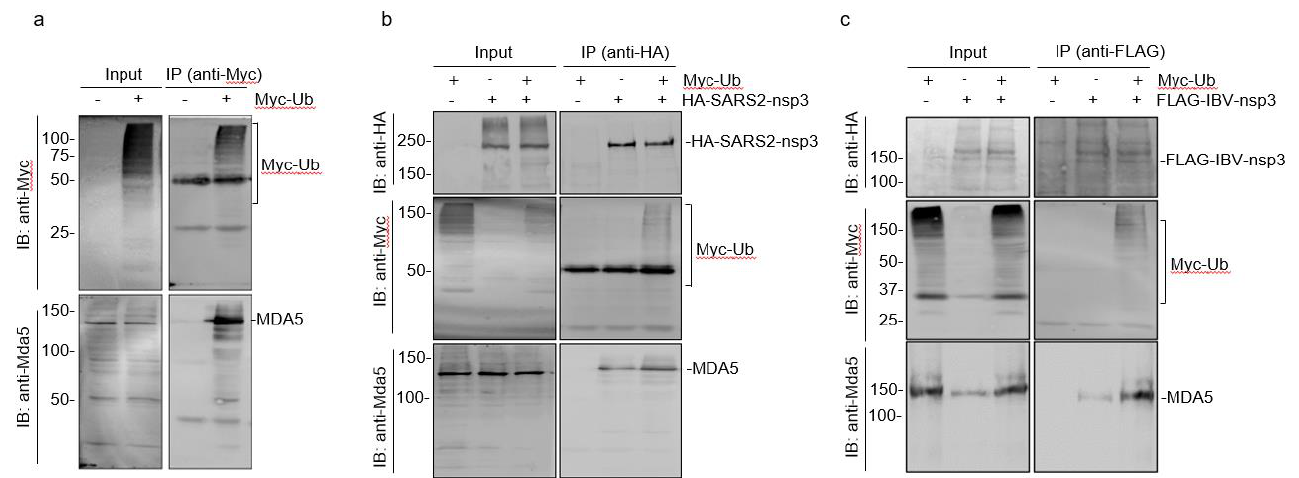
Figure 7. Interaction of ubiquitin and ubiquitinated proteins with nsp3 and MDA5. ( a ) Co-immunoprecipitation of Ub with MDA5. HEK293T cells were transfected with Myc-Ub, harvested at 24 h post-infection, total cell lysates prepared, and subjected to immunoprecipitation with anti-Myc beads. Total cell lysates and precipitates were analyzed by Western blot with anti-Myc and anti-MDA5 antibodies, respectively. Numbers on the left indicate protein sizes in kilodalton. ( b ) Co-immunoprecipitation of HA-tagged SARS-CoV-2 nsp3 with Myc-Ub and MDA5. HEK293T cells were transfected with Myc-Ub alone or together with HA-tagged SARS-CoV-2 nsp3, harvested at 24 h post-infection, total cell lysates prepared, and subjected to immunoprecipitation with anti-HA beads. Total cell lysates and precipitates were analyzed by Western blot with anti-Myc, anti-MDA5, and anti-HA antibodies, respectively. Numbers on the left indicate protein sizes in kilodalton. ( c ) Co-immunoprecipitation of Flag-tagged IBV nsp3 with Myc-Ub and MDA5. HEK293T cells were transfected with Myc-Ub alone or together with Flag-tagged IBV nsp3, harvested at 24 h post-infection, total cell lysates prepared, and subjected to immunoprecipitation with anti-Flag beads. Total cell lysates and precipitates were analyzed by Western blot with anti-Myc, anti-MDA5 and anti-Flag antibodies, respectively. Numbers on the left indicate protein sizes in kilodalton.